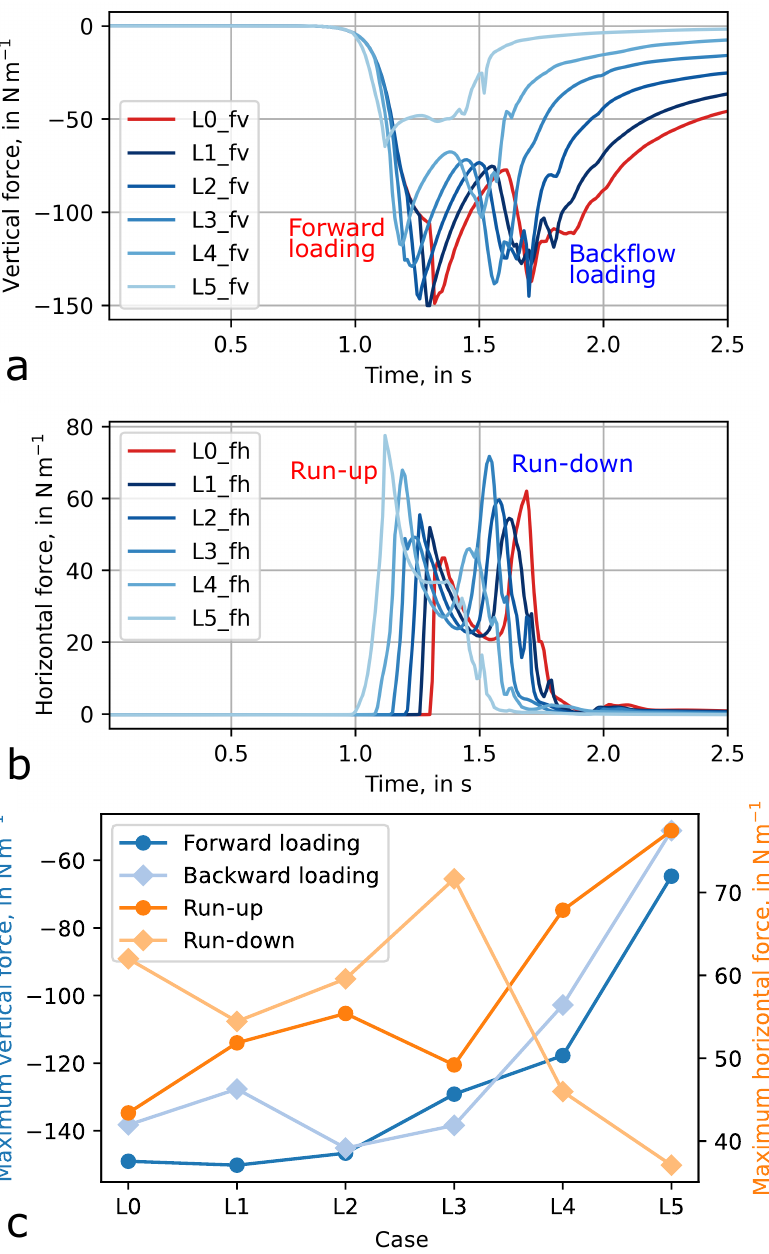
Figure 12. Effect of deck length on shipping water loads. ( a ) Time series of vertical loads per unit length over the complete deck ( f v ) for different deck lengths. ( b ) Time series of vertical loads per unit length over deck wall ( f h ) for different deck lengths. ( c ) Maximum f v and f h loads found in ( a , b ) for all the study cases